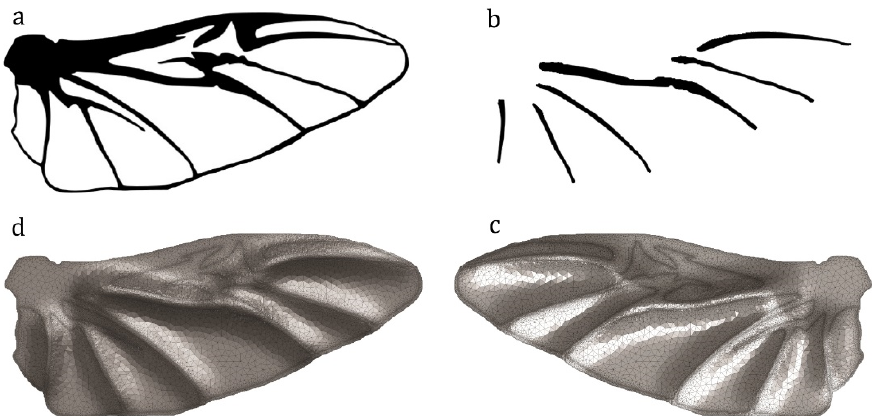
Figure 5. Modeling of the hind wing of the beetle Allomyrina dichotoma (Coleoptera: Scarabaeidae). ( a ) Black and white image of the wing. ( b ) The secondary image for generating corrugations showing the location of the elevated veins. ( c ) Dorsal view of the generated model. ( d ) Ventral view of the generated model.